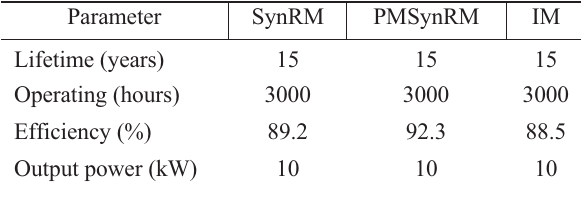
Table 3. Parameters important for the use stage of motors